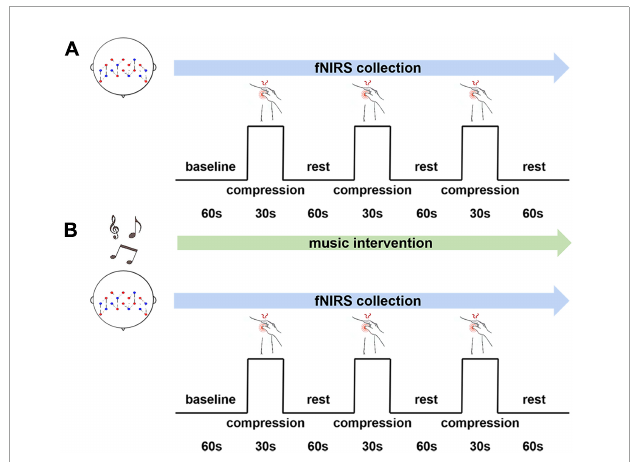
FIGURE1 An experimental paradigm for music intervention. (A) Without music intervention. (B) With music intervention.